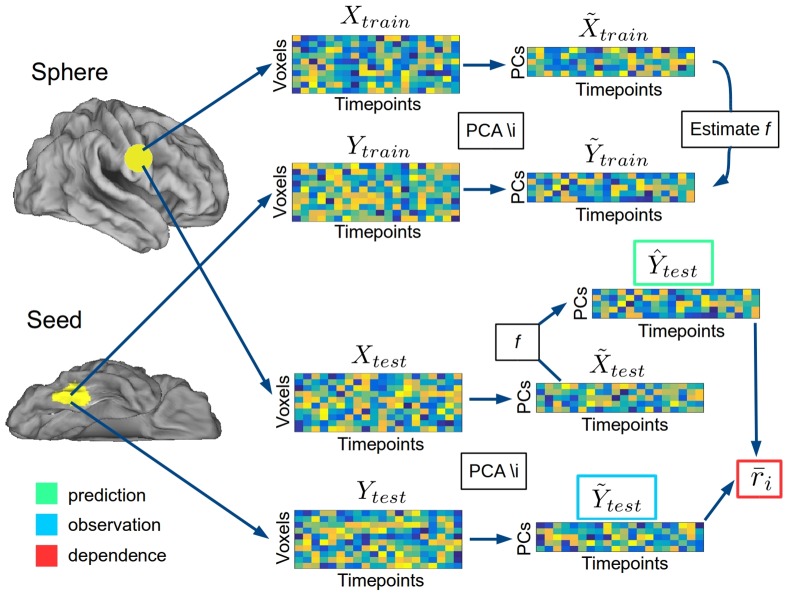
Analysis pipeline.